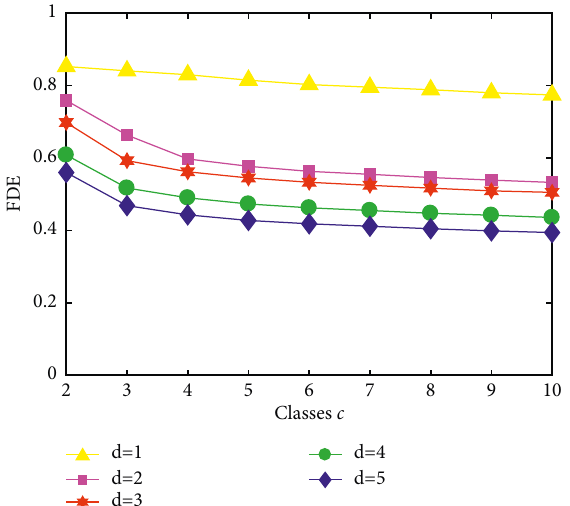
Figure 4: The FDE values of the signal under various time delays.